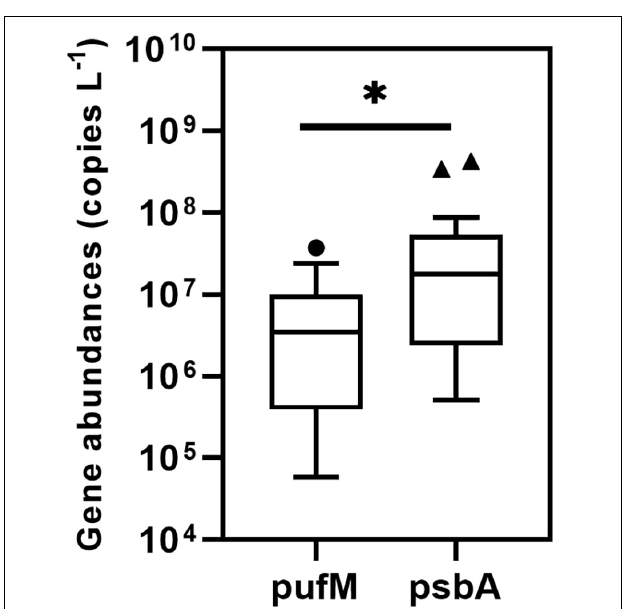
FIGURE 12 | Gene abundance of anoxygenic photosynthesis (AP, puf M) and OP photosystem-II (OP-PSII, psb A) in 49 samples. Note: the puf M gene copy number in KO6_5 m is around 6.39*10 9 copies L − 1 , which is not shown in the figure. ∗ Means the significant difference between two groups ( p <